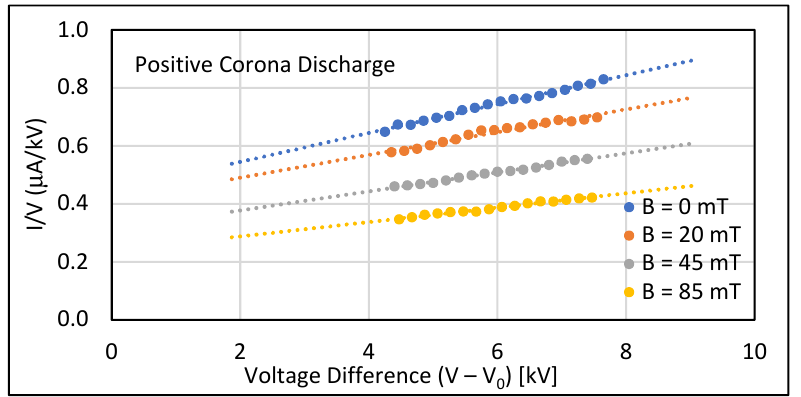
Figure 9. The dependence of I/V versus voltage difference (V − V 0 ) for positive corona at various magnetic field B.